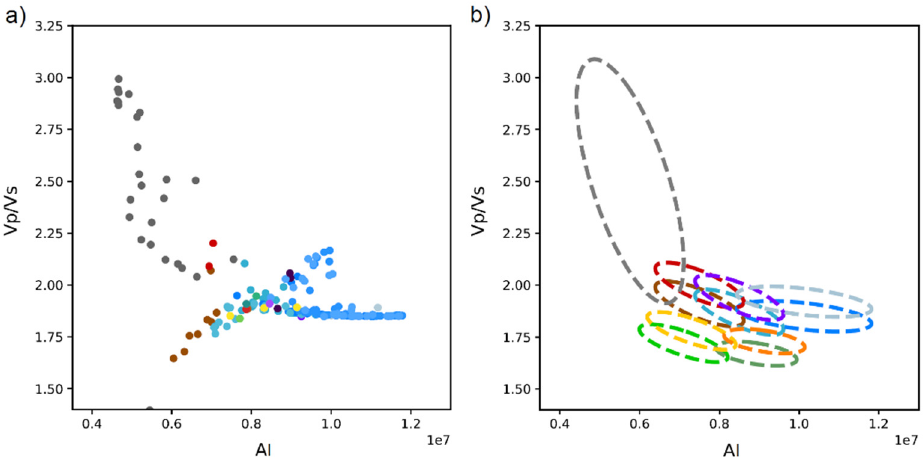
Figure 10. Acoustic impedance (AI) versus Vp/Vs: ( a ) data from the NW-Adda-1X that contain shear sonic measurements; ( b ) the corresponding rock physics model likelihoods (RPMs) defined from the data and fluid substitution modeling. The large gray ellipse represents the over- and underburden RPMs. Refer to Figure 6 for the facies